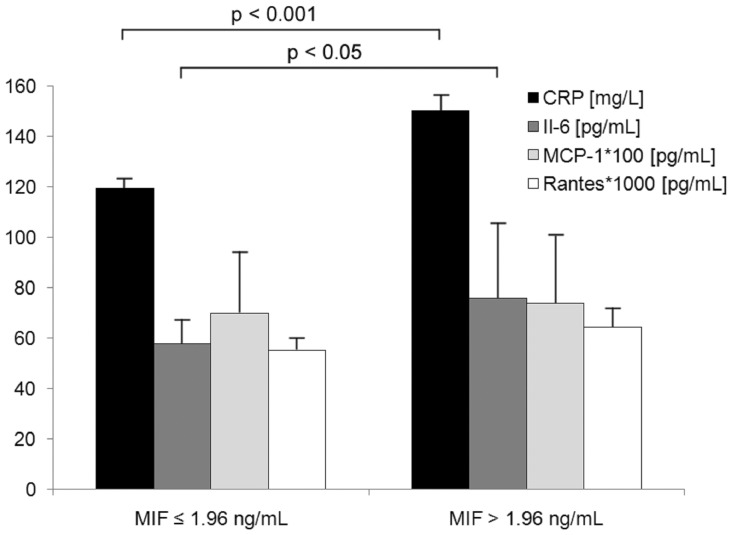
Association of inflammatory markers IL-6, RANTES, MCP-1 and CRP with MIF levels in the study cohort.